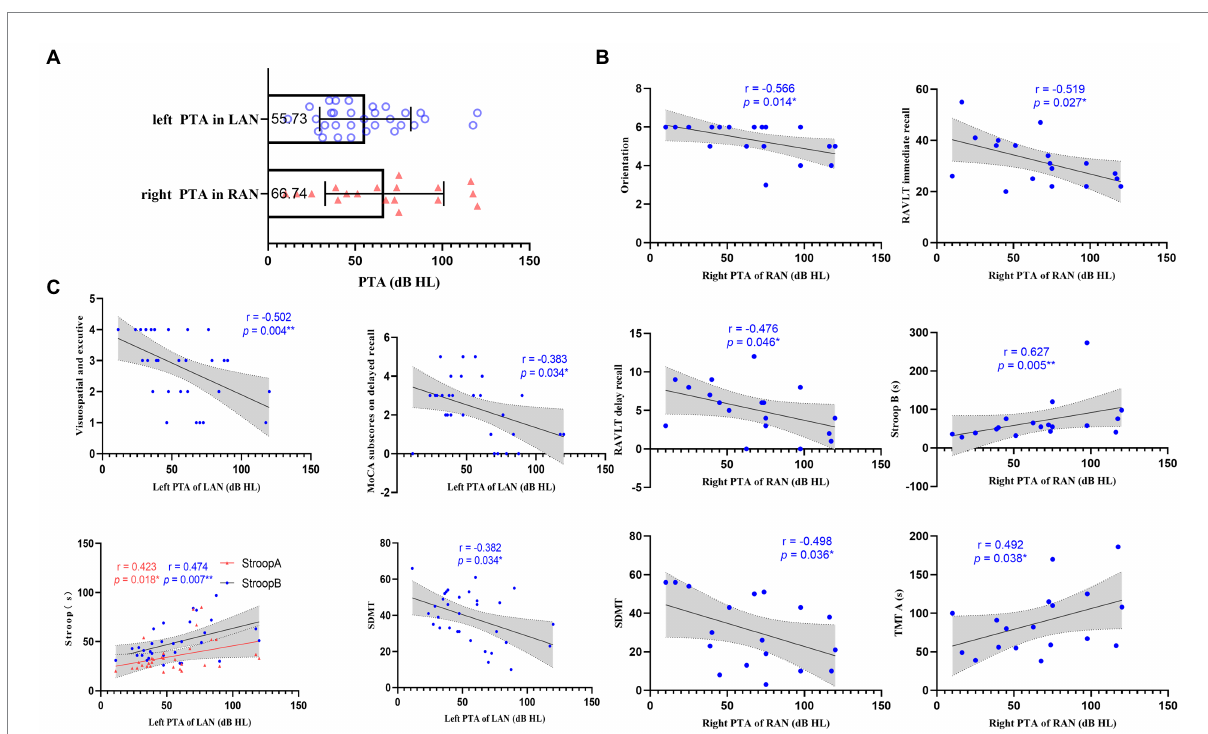
FIGURE 1 Relation between pure tone average (PTA) and cognition. (A) Scatter plots representing the distribution of PTA in the left acoustic neuroma (LAN) and right acoustic neuroma (RAN) groups. The numbers in the box represent the average PTA of the affected side in LAN and RAN patients, respectively. (B) Scatterplots showing the associations between right PTA and cognitive scale in the RAN patients. (C) Scatterplots showing the correlations between left PTA and cognitive scale in the LAN patients. The correlation analysis between PTA and cognition shows that hearing loss in AN patients affects cognitive functions such as visuospatial executive, memory, attention, motor speed, visual perception, and executive control. Error bars in (A) represent mean ± standard deviation. The gray regions in (B,C) show a 95% confidence interval. *, p < 0.05;**, p <